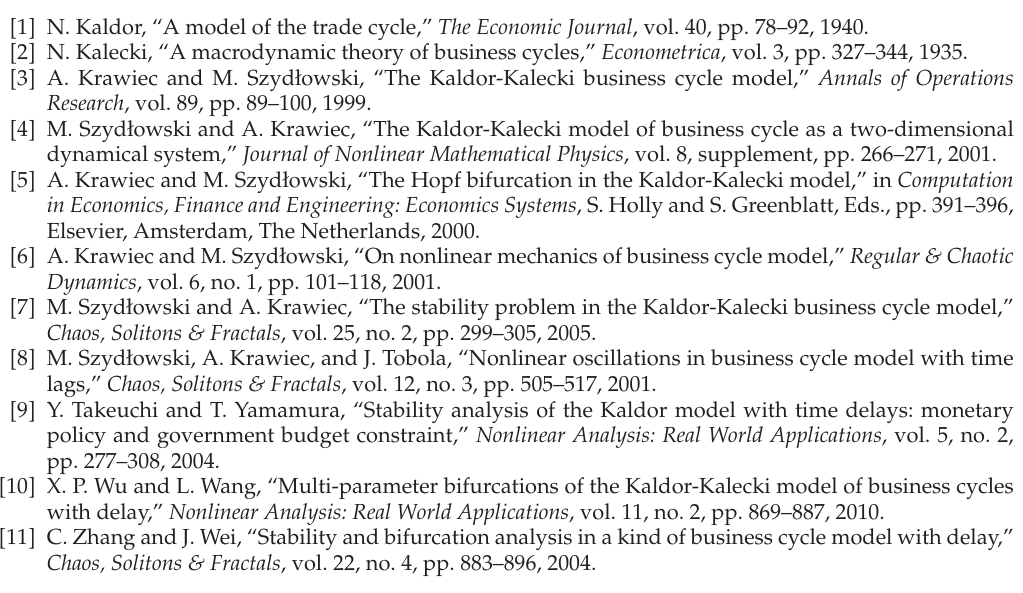
Figure 4: Two large limit cycles are generated when (cid:5) μ 1 ,μ 2 (cid:6) is in the region between C